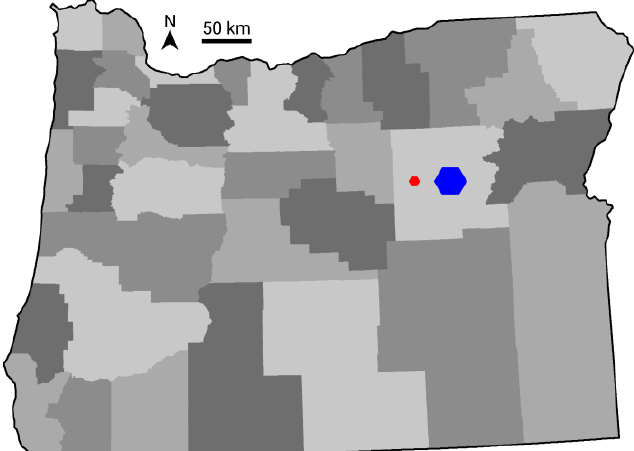
Figure 1. The state of Oregon, illustrating the locations of 36 counties (shades of gray) and the relative size of districts (red) and regions (blue).